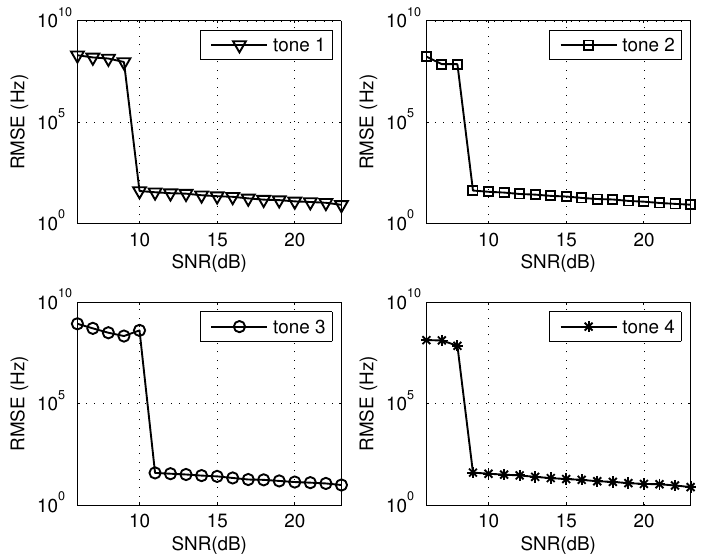
Figure 6. RMSE results of four tones utilizing the all-phase DFT.